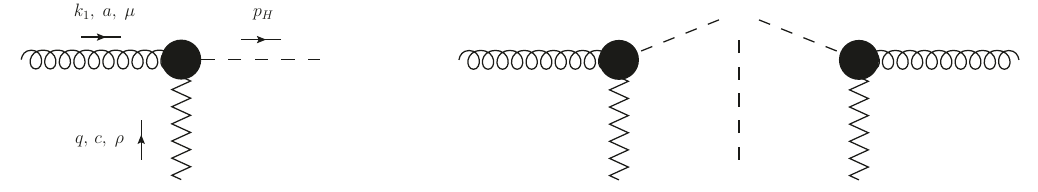
Figure 5 . Born gluon-Reggeon-Higgs effective vertex (left) and schematic description of the single contribution to the impact factor LO (right). We draw the Higgs boson above the cut to emphasize that we do not integrate over its kinematic